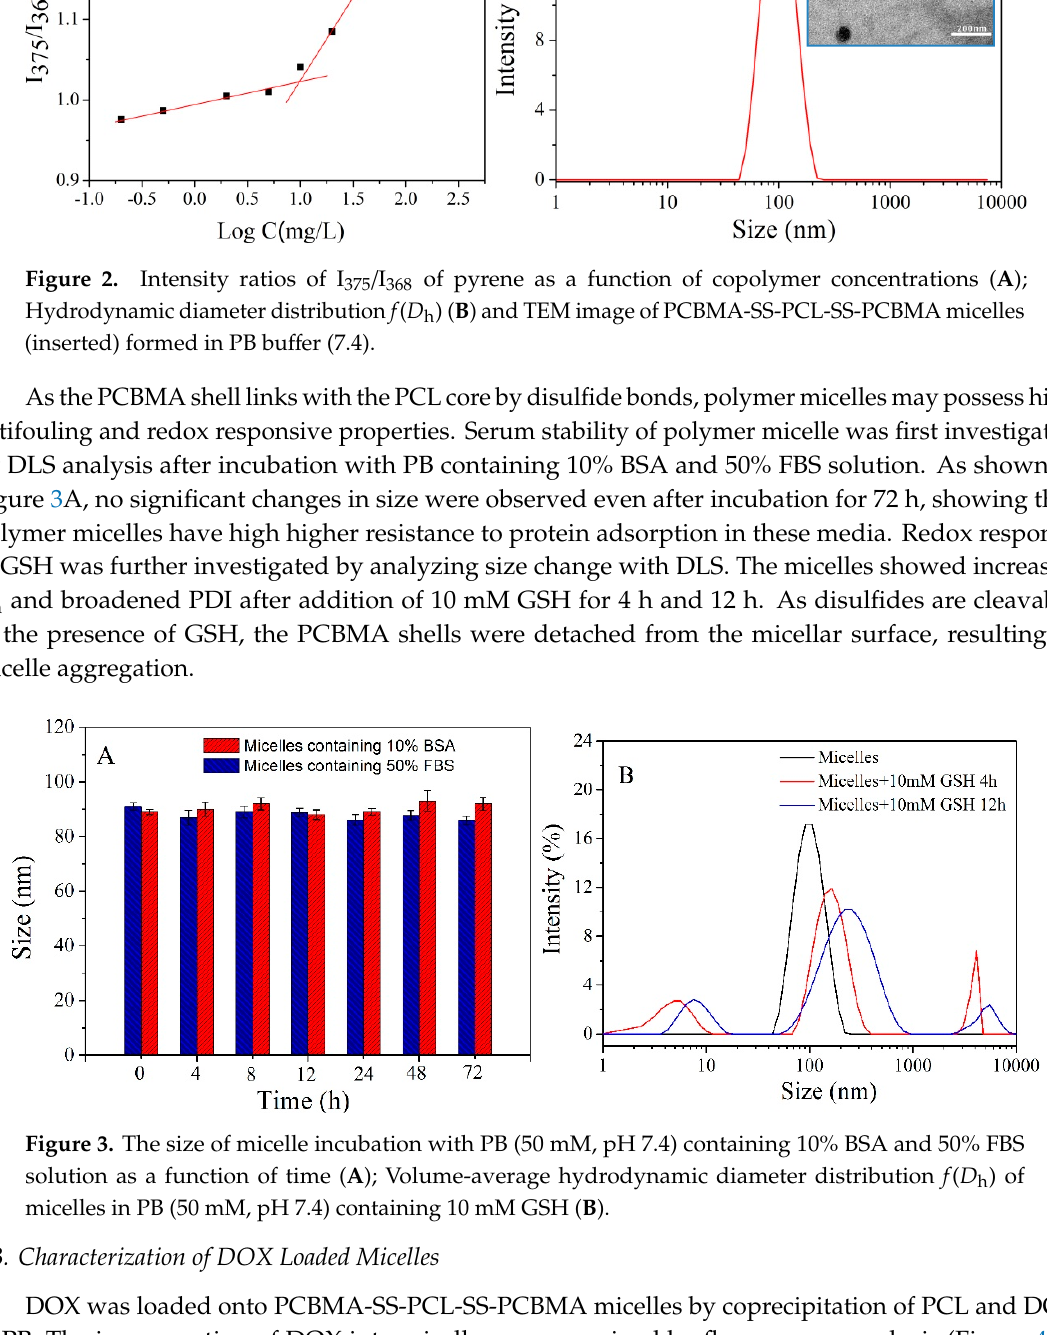
micelles in PB (50 mM, pH 7.4) containing 10 mM GSH ( B ).